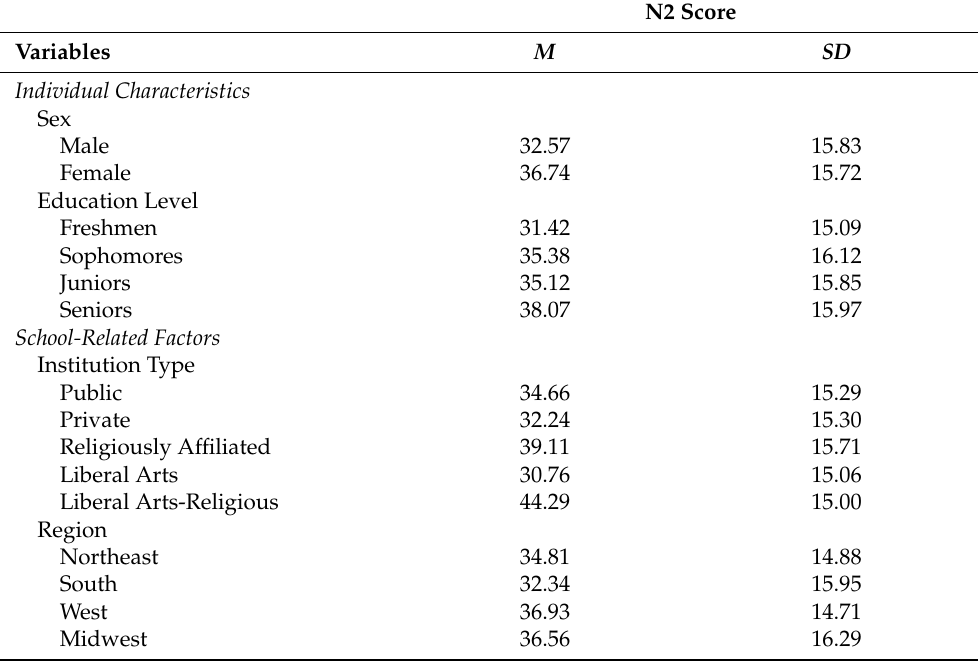
Table 1. Descriptive Statistics for N2 Scores as Functions of Individual and Institutional Factors.